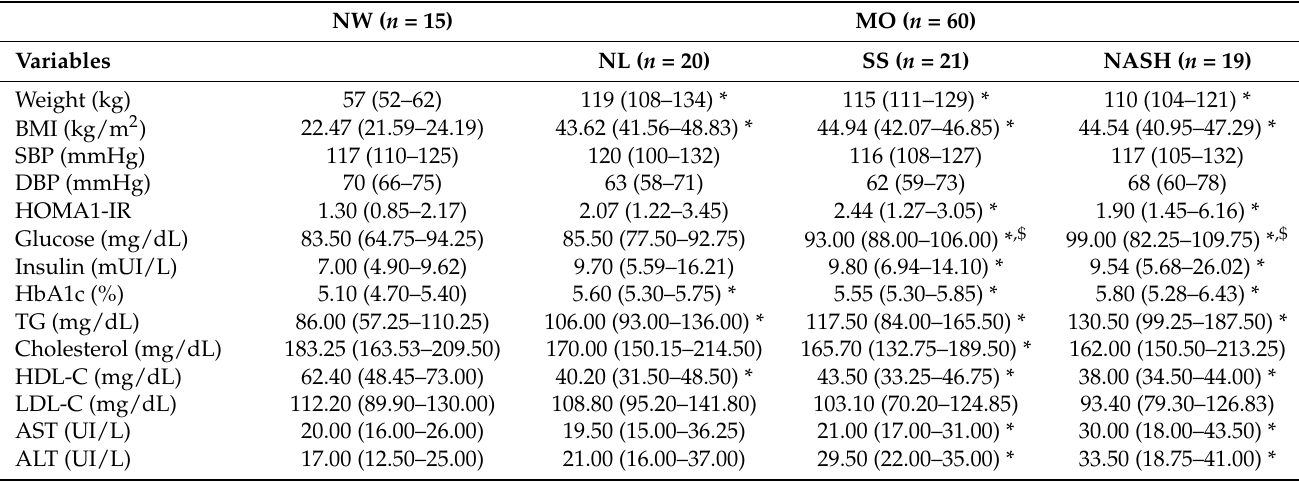
Table 1. Anthropometric and biochemical variables of women in the studied